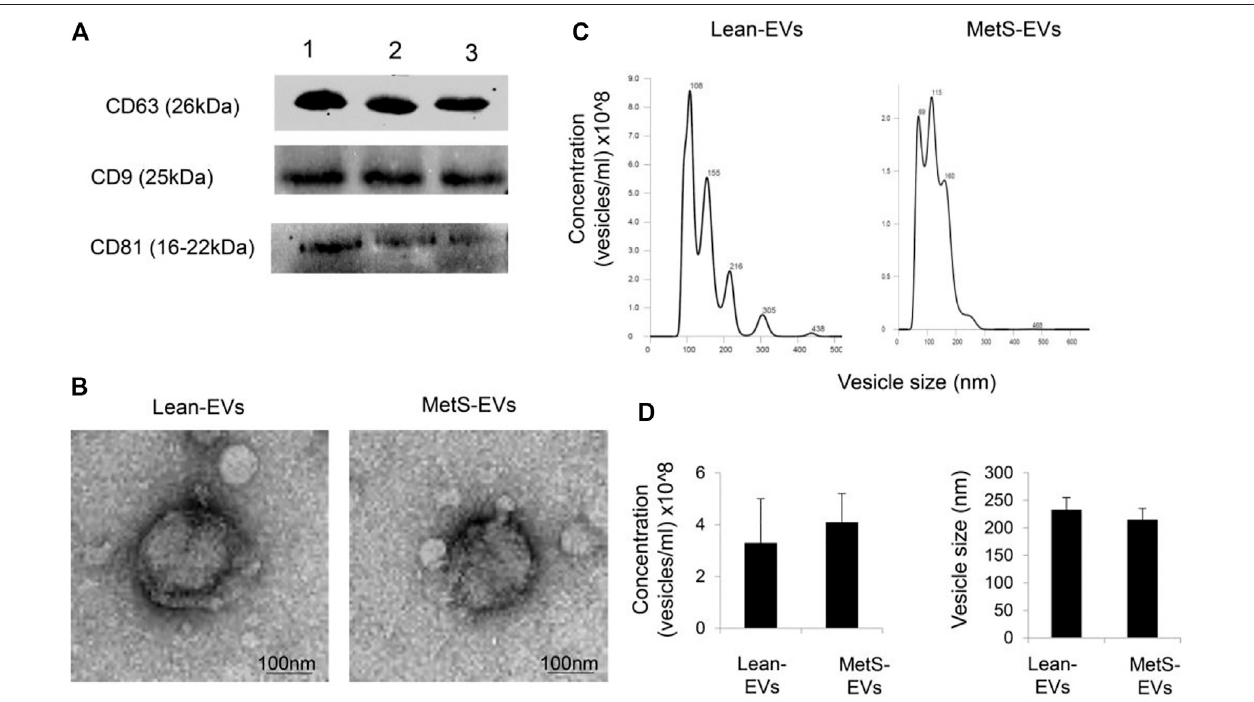
FIGURE 1 | (A) Circulating EVs expressed common EV markers, including CD9, CD63, and CD81, by western blotting. (B) Transmission electron microscopy showingcirculating Lean-andMetS-EVsexhibitingtheclassic “ cup-like ” morphology. (C) Representativesize-distribution curve ofLean-andMetS-EVs bynanoparticle tracking analysis (NTA). (D) Quanti fi cation showed comparable EV concentration and size by NTA between the groups (Student ’ s t